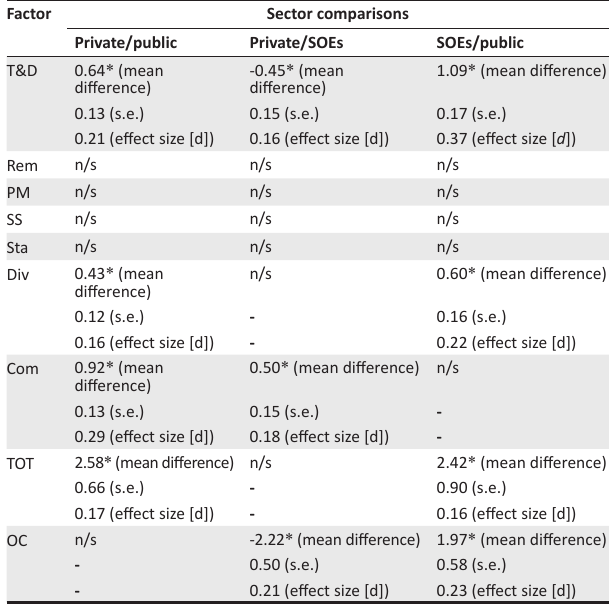
TABLE 3: Scheffé post hoc test: Between sectors mean score differences (practically significant differences are